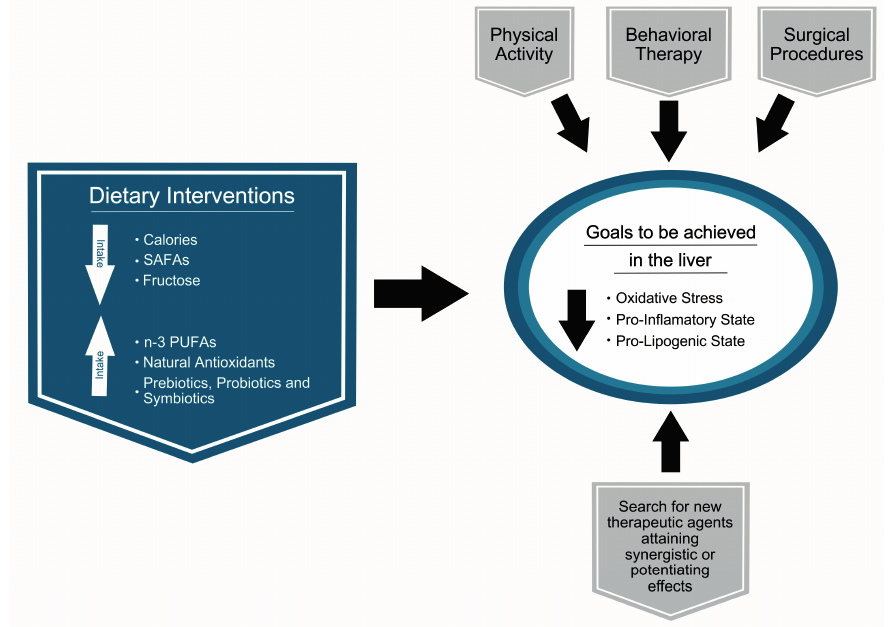
Figure 1. Interventions for the prevention and treatment of non-alcoholic fatty liver disease (NAFLD). Abbreviations : n-3 PUFAs, n-3 polyunsaturated fatty acids; SAFAs, saturated fatty